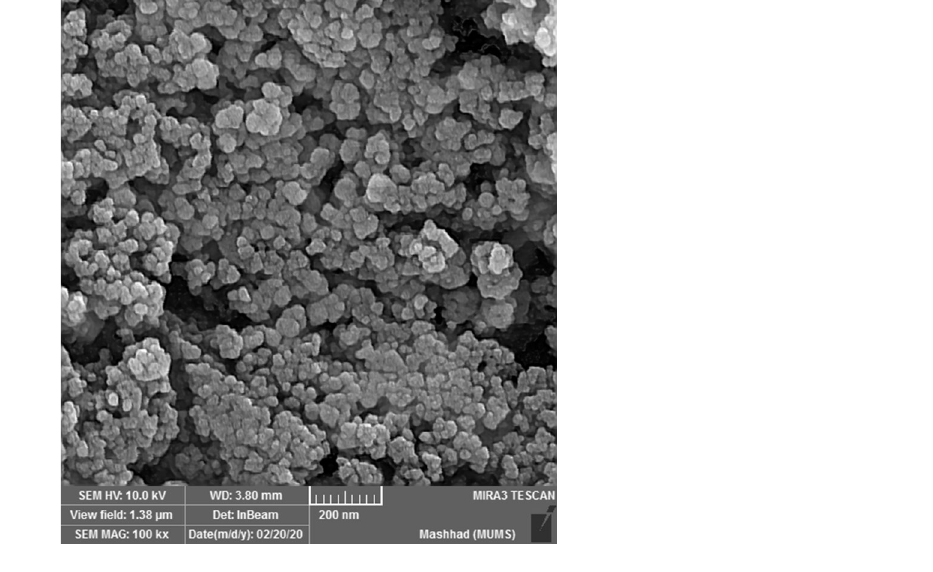
Figure 5. SEM image of MS/Ag 2 CO 3 .